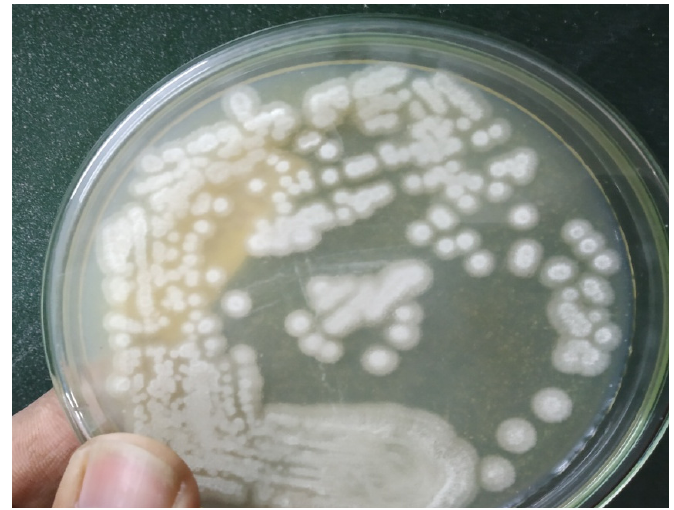
Fig. 4. Isolate GRC1 exhibiting white mycelia.